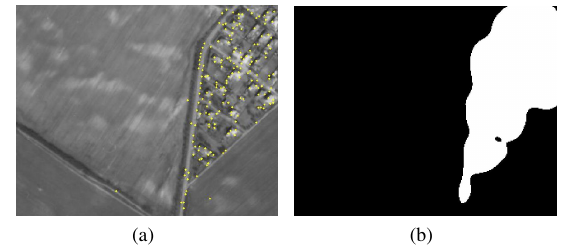
Figure 3: Urban area detection with spatial voting: (a) shows the original image; (b) is the detected urban area.